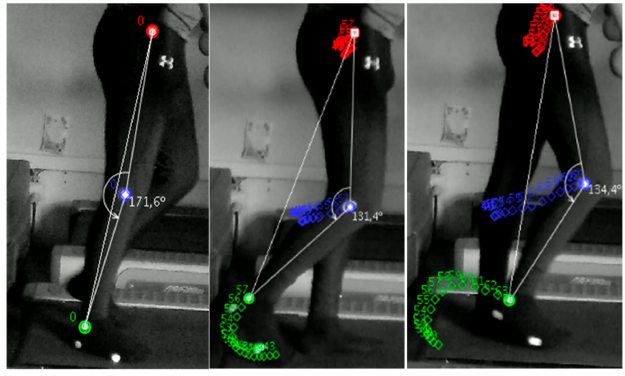
Figure 4. Triangular